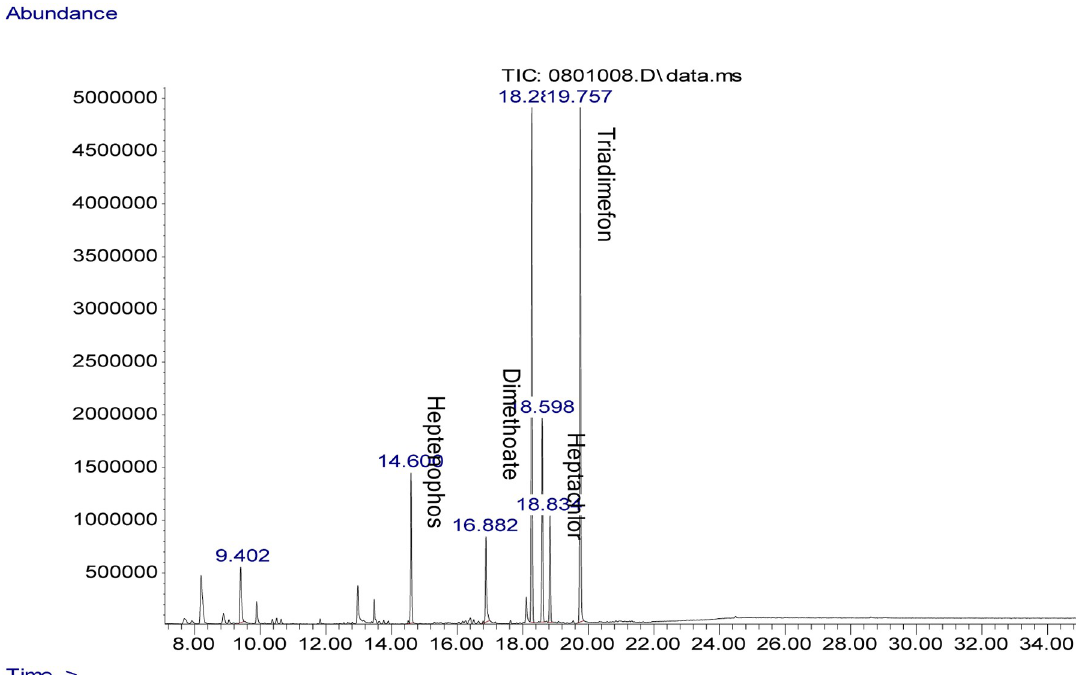
Fig 4. Chromatogram of triadimefon, dimethoate and heptenophos in tomato.